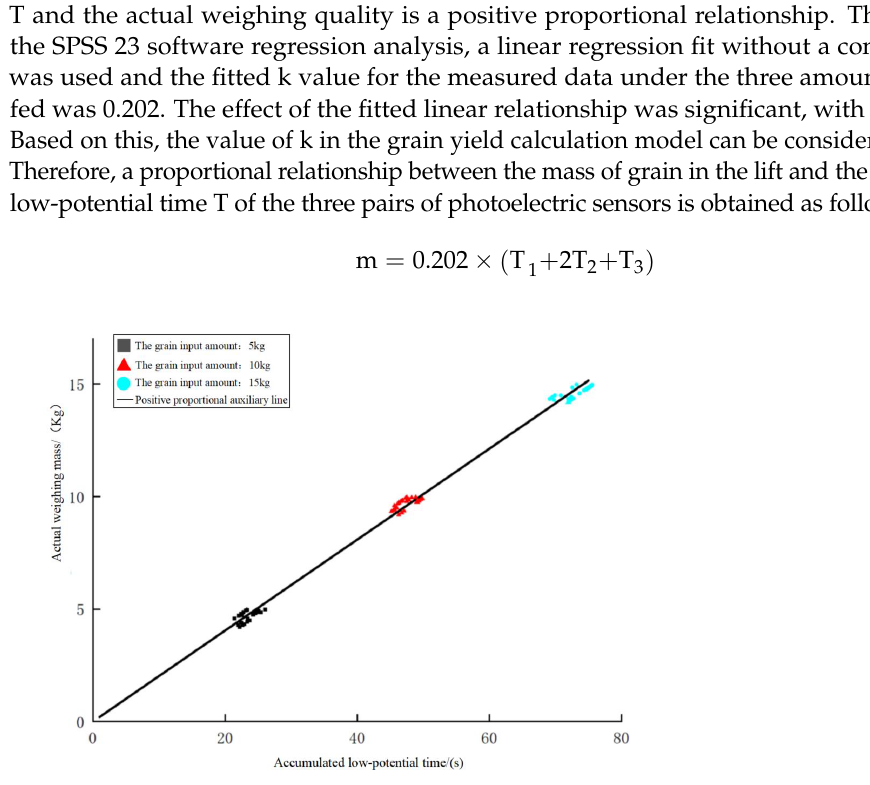
Figure 5. Fitted line between bench test data and low-potential accumulation time at different feed rates. 2.3. Validation of Yield Measurement Model Accuracy The actual harvesting operation of the maize seed harvester may vary in terms of harvesting speed, number of rows harvested and the undulation of the ground in the field, resulting in different grain feed, hoist sprocket speed and elevator tilt angle. Therefore, three working conditions were set up in this paper to verify the accuracy of the yield cal- culation model. Working condition 1 was when the motor speed was 150 r/min and the tilt angle of the elevator was 26°. We verified the accuracy of the yield measurement with 3 grain input amounts (5 kg, 10 kg, 15 kg). Working condition 2 was when the grain input amount was 10 kg and the elevator was tilted at an angle of 26°. We verified the accuracy of the yield measurement with 3 motor speeds (120 r/min, 150 r/min, 190 r/min). Working condition 3 was when the grain input amount was 10 kg and the motor speed was 150 r/min. We verified the accuracy of the yield measurement with 3 tilt angles of the elevator (20°, 26°, 30°). Each variable condition was tested 5 times in each working condition, for a total of 15 tests.